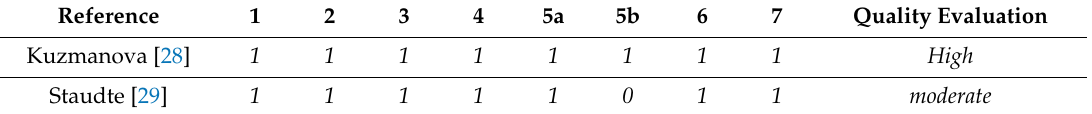
Table 2. The results of the critical appraisal assessments for case-control